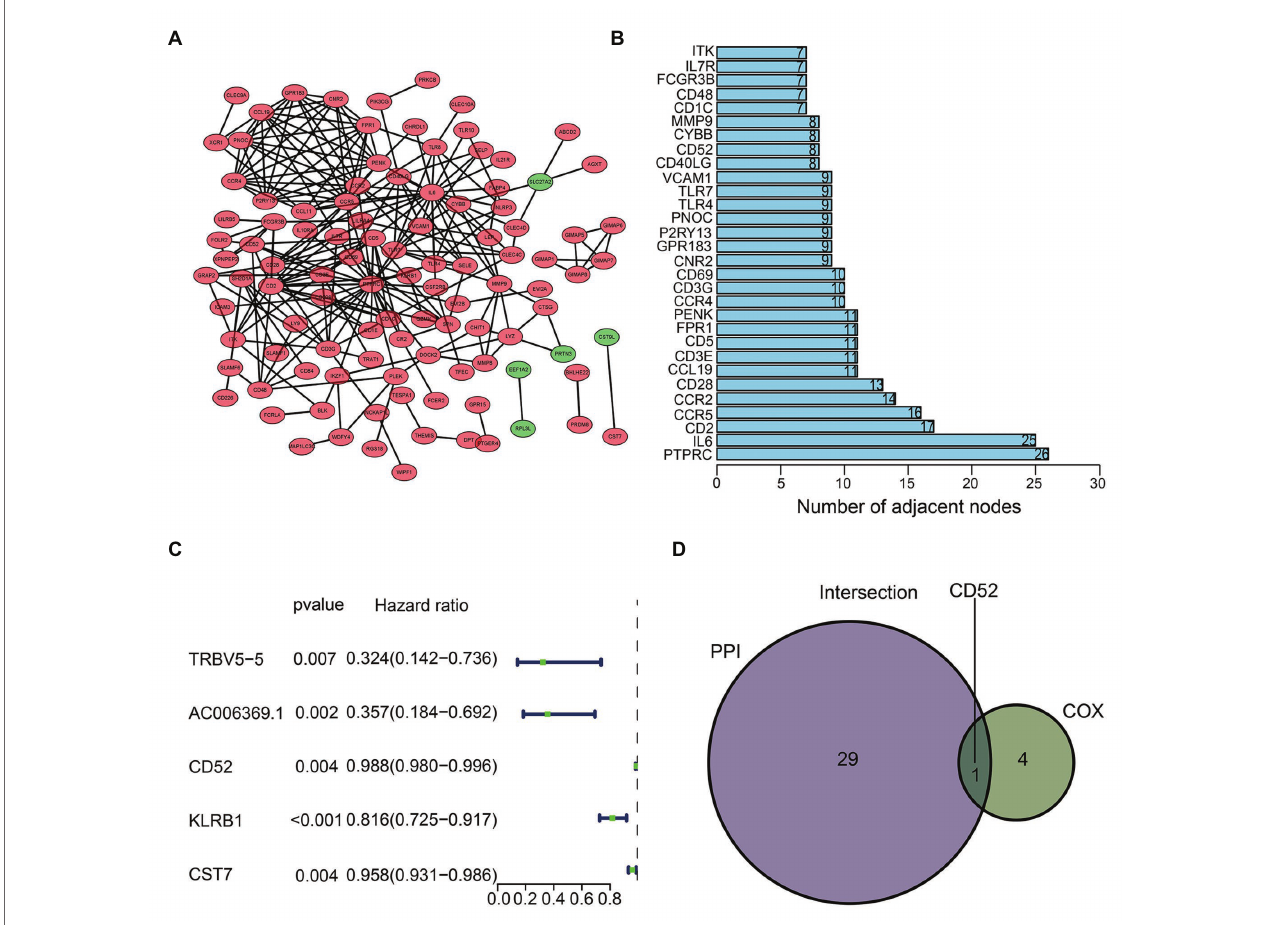
FIGURE 3 | Protein-protein interaction (PPI) network and Cox regression analysis. (A) Construction of interaction network. (B) The number of nodes orders the top 30 genes. (C) Forest plot of Cox regression analysis. (D) Venn plot showing the sharing factors by the top 30 genes in PPI and significant genes in